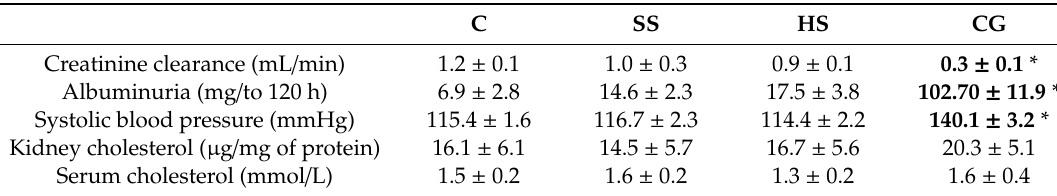
Table 3. General characteristics in the experimental